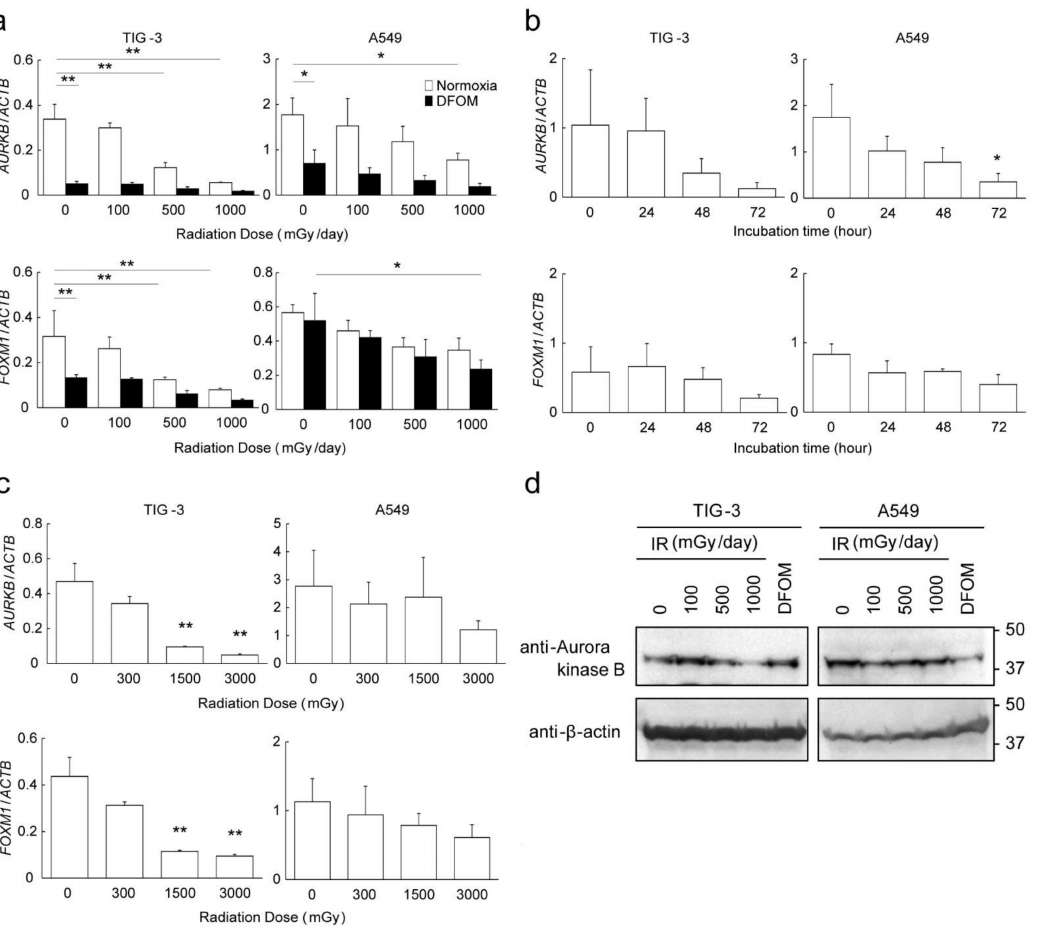
Figure 3. Effects of LDR-IR on the expression of AURKB and FOXM1 . Expression levels of AURKB and FOXM1 were evaluated by quantitative RT-PCR. ( a ) TIG-3 and A549 cells were irradiated with 100, 500, or 1000 mGy of γ -rays per day for 3 days under normoxic or DFOM-treated conditions. ( b ) Cell lines were treated with DFOM for 24, 48, and 72 h. ( c ) Cell lines were irradiated with 300, 1500, or 3000 mGy of γ -rays, the same total doses as in the LDR-IR experiment above but with instantaneous exposure. ( a – c ): Relative gene expression levels were calculated as the ratio to ACTB expression. Values are represented as means and SD ( n = 3). * p < 0.05; ** p < 0.01. ( d ) Protein levels of Aurora kinase B in LDR-irradiated or DFOM-treated TIG-3 and A549 cells were analyzed via immunoblotting. β -actin was used as an internal loading control. Representative images are shown from three independent